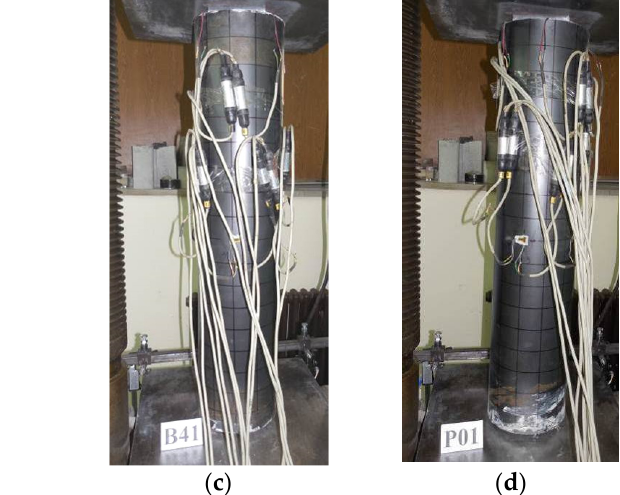
Figure 4. Column specimens before the experiment. Plain RC column ( a ) and strengthened columns ( b – d ).